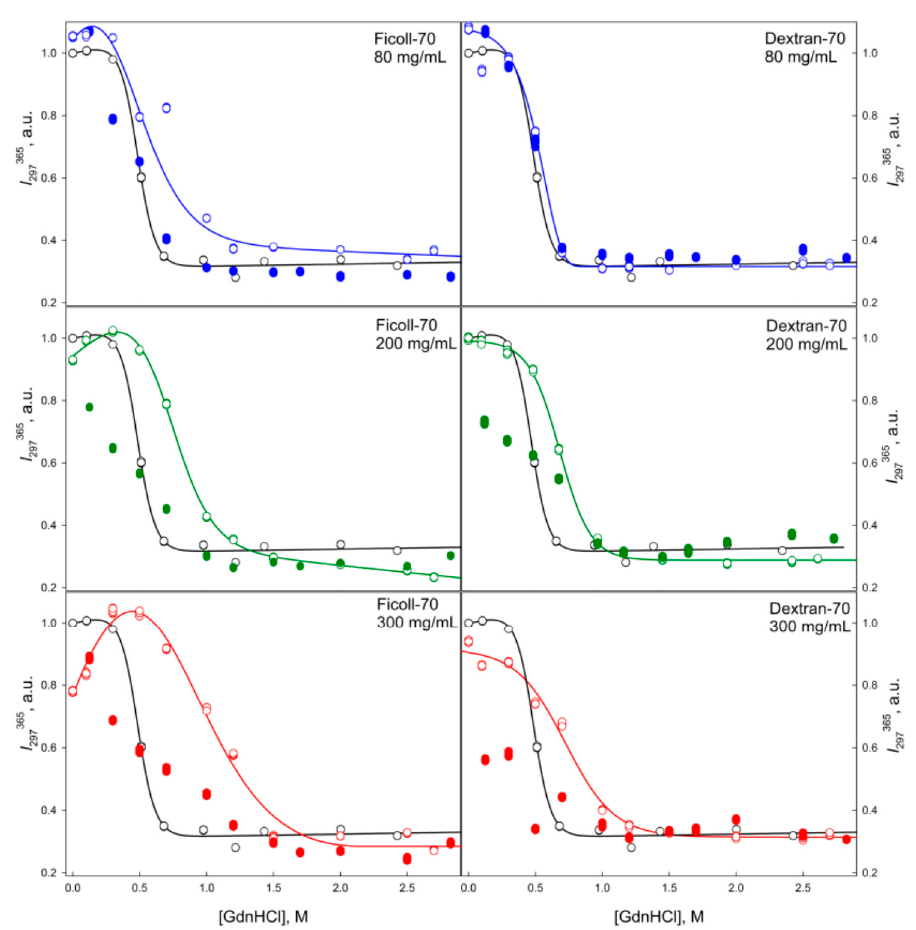
Figure 7. Unfolding/refolding transitions of GGBP in the presence of different concentrations of Ficoll-70 and Dextran-70 recorded as the dependence of the intrinsic fluorescence intensity of GGBP on GdnHCl concentration. The excitation wavelength was 297 nm, emission wavelength was 365 nm. Other designations as in Figure 4.